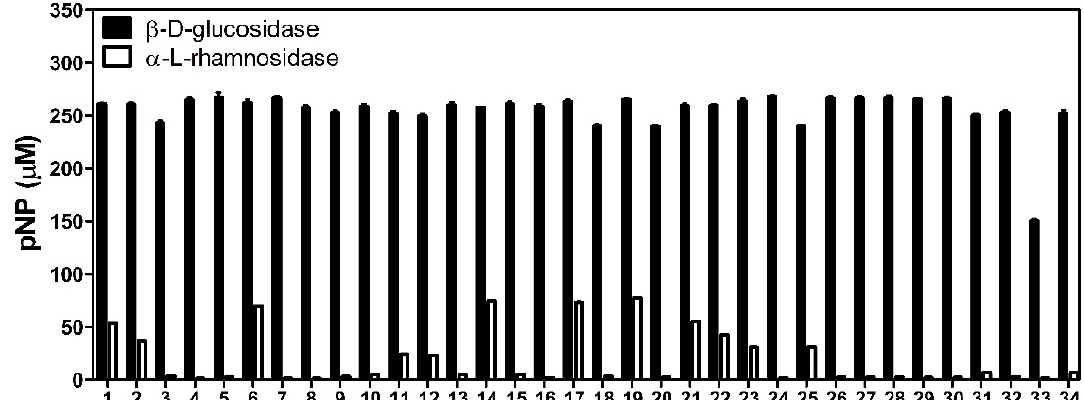
Figure 2. α - L -rhamnosidase and β - D -glucosidase activities of 34 LAB strains isolated from kimchi.